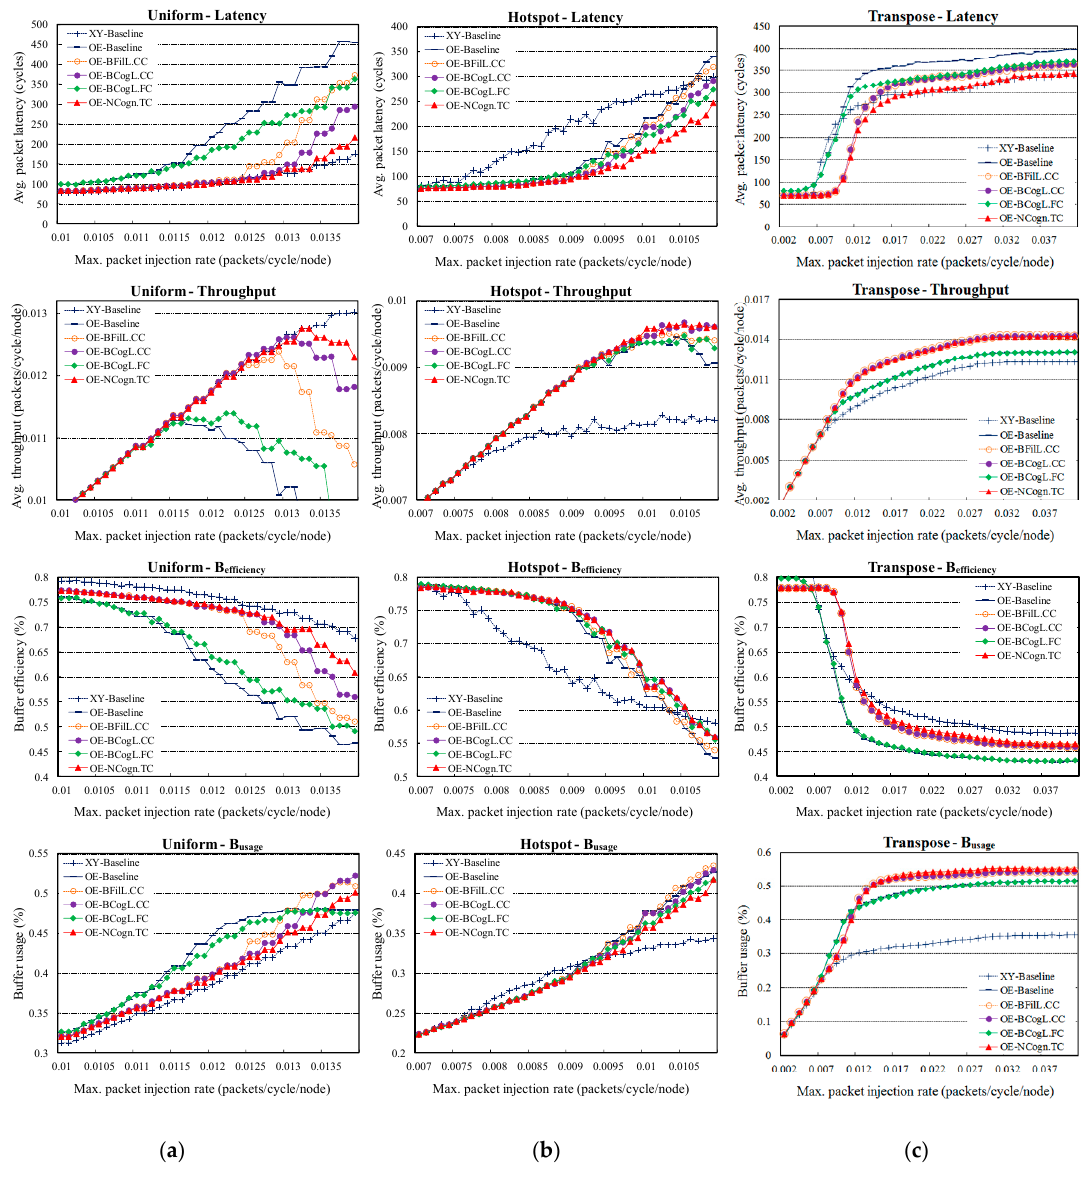
Figure 14. Performance variations in latency (top), throughput (top-middle), buffer efficiency (bottom-middle), and buffer usage (bottom) under ( a ) uniform, ( b ) hotspot, and ( c ) transpose traffics.